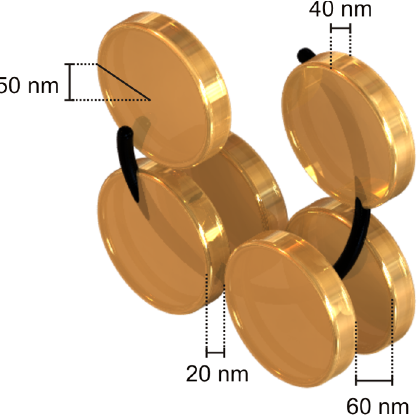
FIG. 9. Sketch of the chiral plasmonic oligomer. The arrange- ment of the gold disks mimics the chiral structure of a left- handed helix.